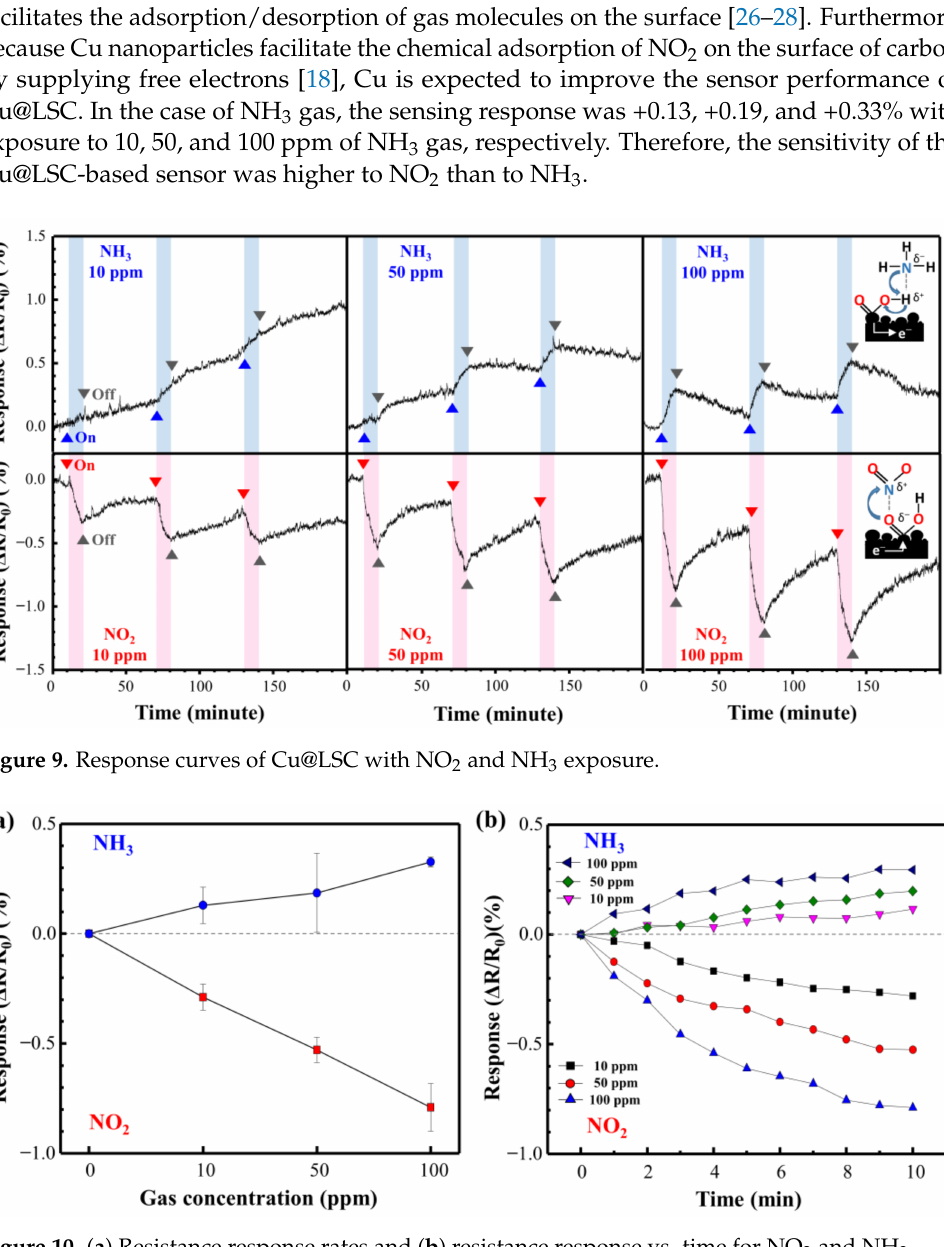
Figure 10. ( a ) Resistance response rates and ( b ) resistance response vs. time for NO 2 and NH 3